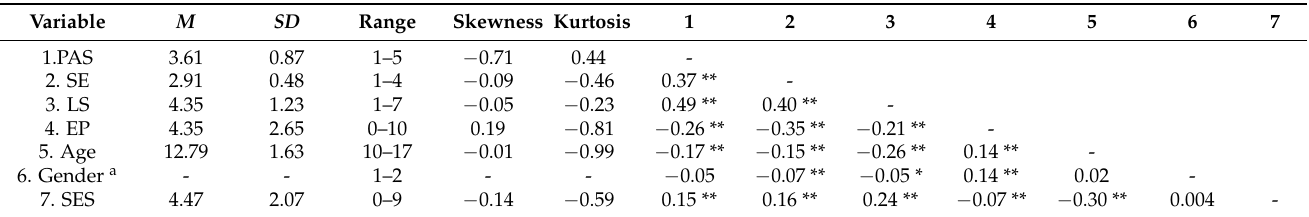
Table 1. Descriptive statistics and bivariate correlations between variables in Study